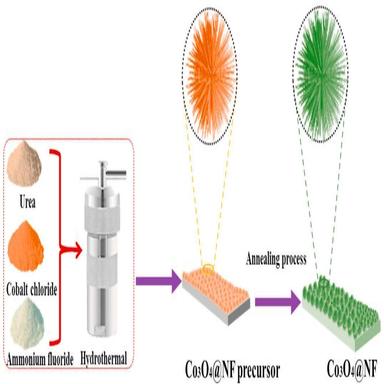
Illustration for the fabrication process of the binder-free Co3O4@NF electrodes.